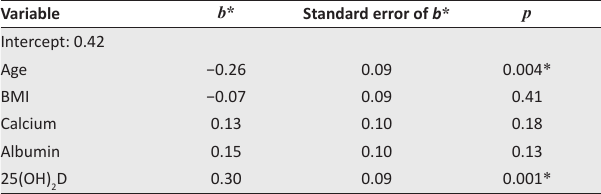
TABLE 3: COVID-19 severity regression model.